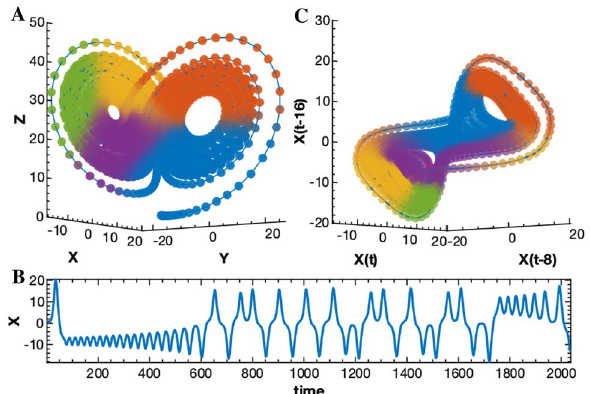
Figure 6. Illustration of Takens’ theorem. ( A ) A Lorenz attractor with time points colored according to proximity. ( B ) Time series of the x coordinate. ( C ) Delay reconstruction from lagged x coordinates. The timepoints have the same colors as those in ( A ). Notice how the delay reconstruction preserves the relative locations of the time points despite being transformed and warped. This demonstrates the homeomorphism between the two